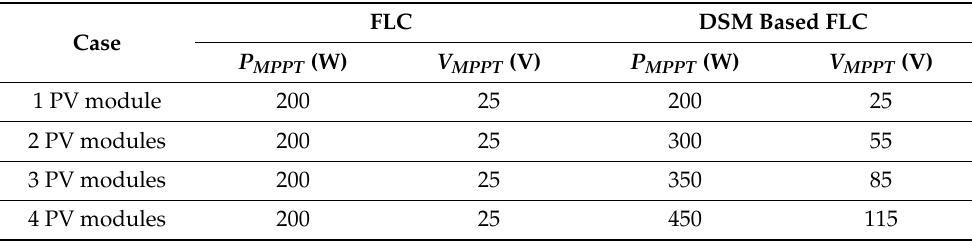
Table 2. Summary of simulation results.